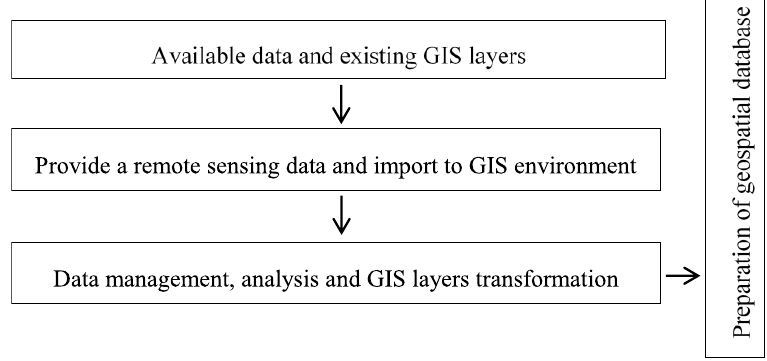
Figure 2. GIS framework for preparation of a geospatial database.